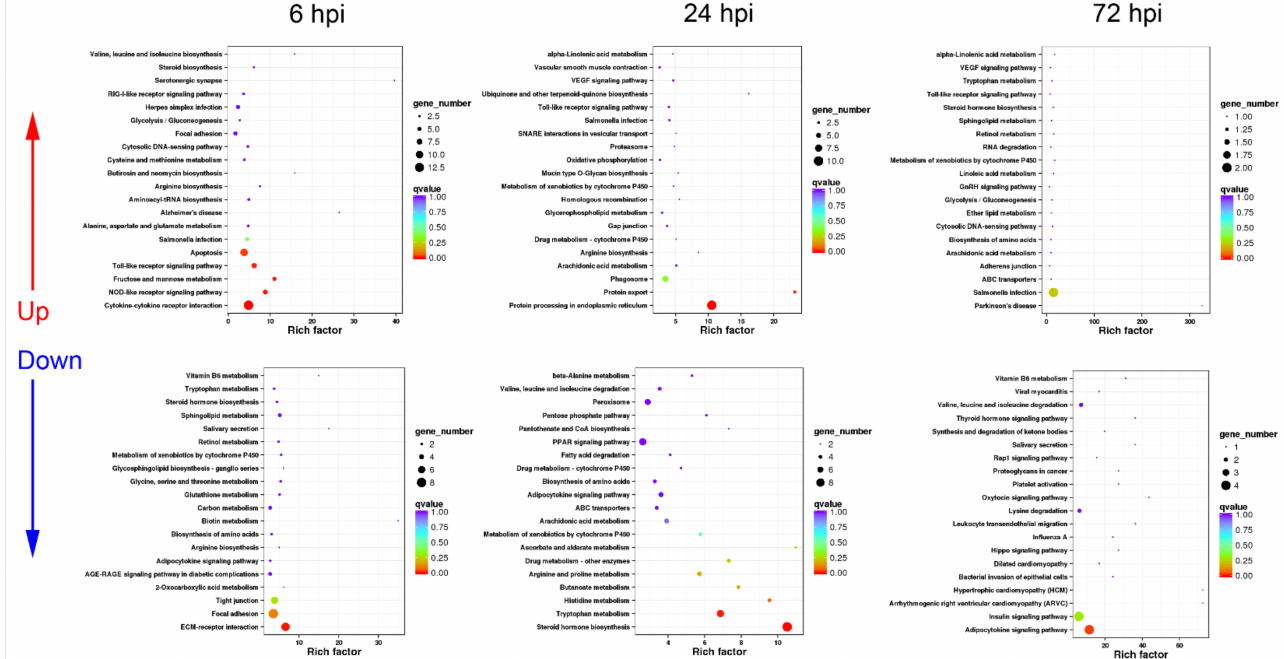
Figure 4. KEGG enrichment analysis in IL group turtles at different time periods. The top 20 KEGG pathways are presented here in the form of scatterplots to show the up-regulated and down-regulated DEGs enriched in livers from inactive subgroup turtles at 6, 12, and 72 hpi. The enrichment factor is the ratio between the DEG number and the number of all genes in a certain gene enrichment term. The sizes of the dots on these plots denote the number of DEGs, while colors correspond to the q value